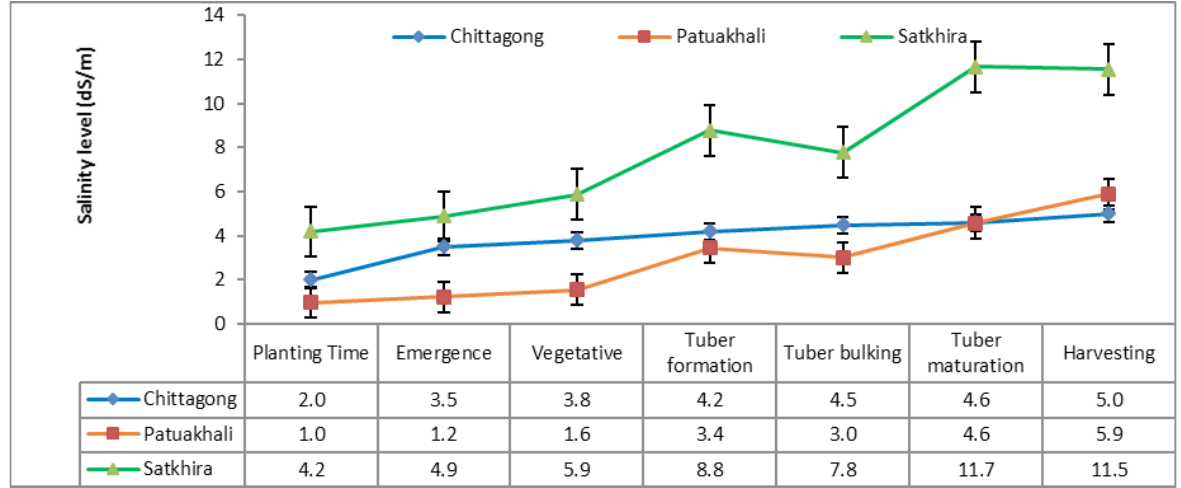
Figure 3: Salinity level of salt tolerance trial (farmers’ field trials) during different growth to harvesting stages of potatoes at Chittagong, Patuakhali & Satkhira during 2014-15 crop season